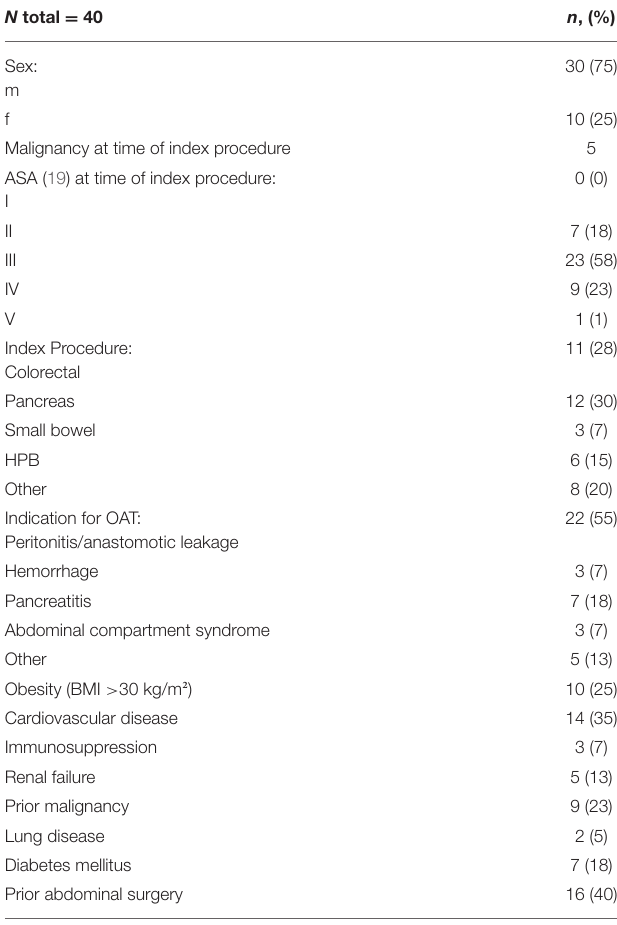
TABLE 1 | Epidemiologic data, comorbidities and potential influencing factors of postoperative